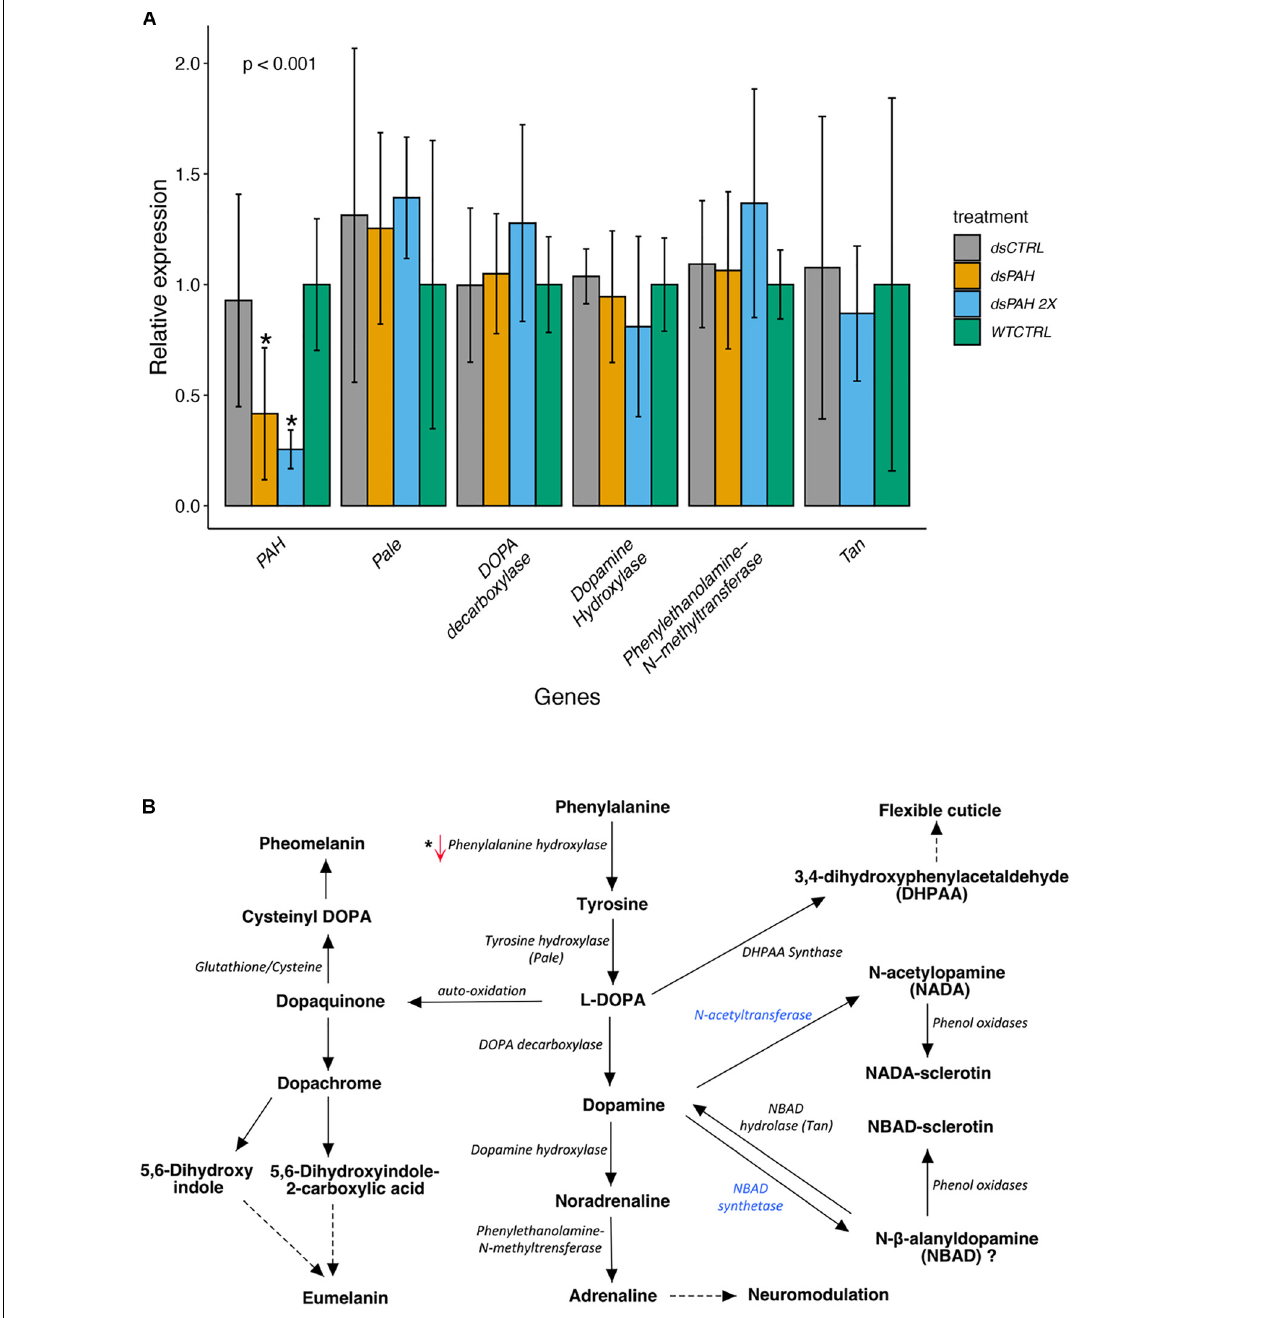
FIGURE 4 | Gene expression of various genes following dsRNA treatment. (A) RT-qPCR determination of the various genes in Phenylalanine metabolism pathway. The expression level of LsPAH , LsPale and other genes involved in catecholamine synthesis pathway of dsRNA treated larvae, relative to expression level of the dsRNA controls. The Elf1 α and ADT3 genes were used for data normalization. The data were analyzed with one-way ANOVA for the downregulation and statistically significant results are marked with asterisk ( p < 0.001). ds PAH , dsRNA Phenylalanine hydroxylase; dsCTRL, non-specific dsRNA and WTCTRL, Wildtype on seawater only. Each treatment contained 5 to 8 biological replicates. (B) The metabolic pathway of phenylalanine metabolism. The gene changes in transcriptional levels are marked by upward and downward arrows for upregulation and downregulation, respectively. Blue color indicates the absence of the gene in L. salmonis.